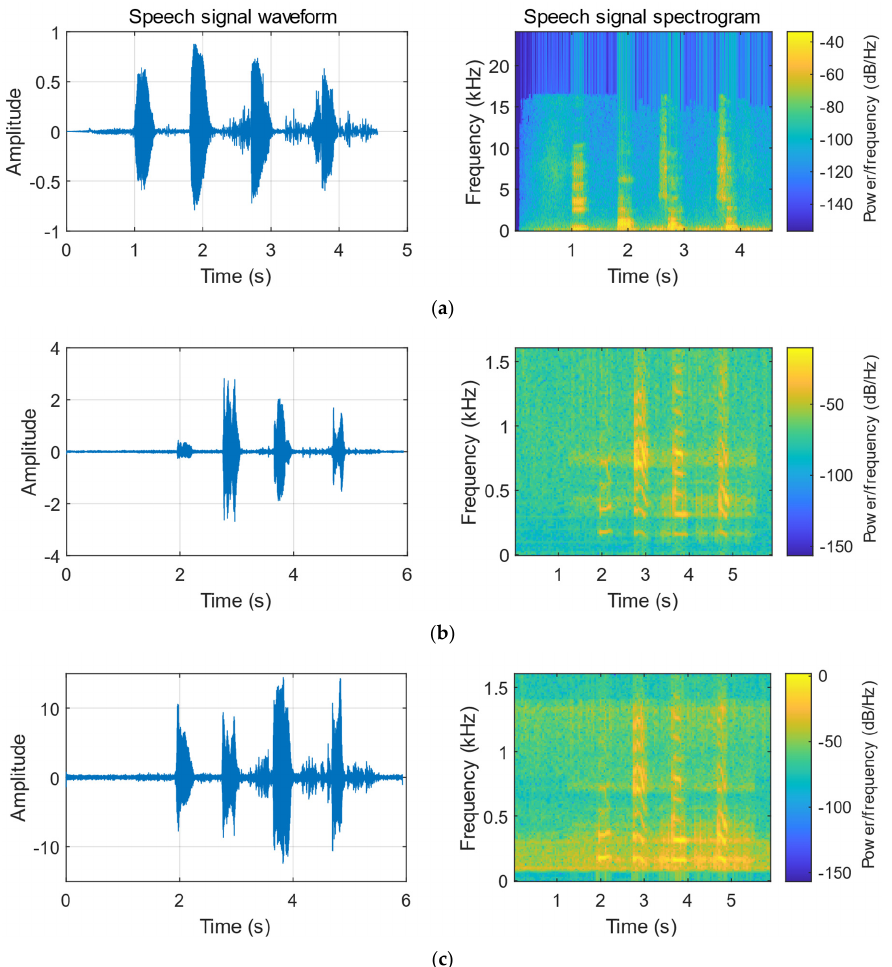
Figure 15. Comparison of speech signals reconstructed using the fiber laser. ( a ) Original speech signal. ( b ) Speech signal reconstructed by DIC. ( c ) Speech signal reconstructed by DIC + speech enhancement.